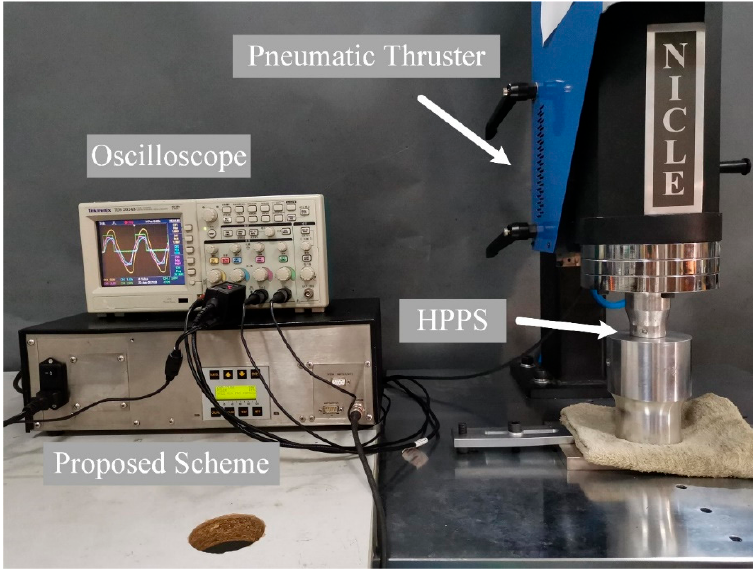
Figure 12. Experimental setup of frequency tracking verification.